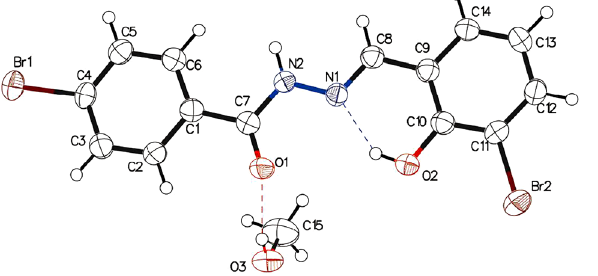
Table  : Data collection and